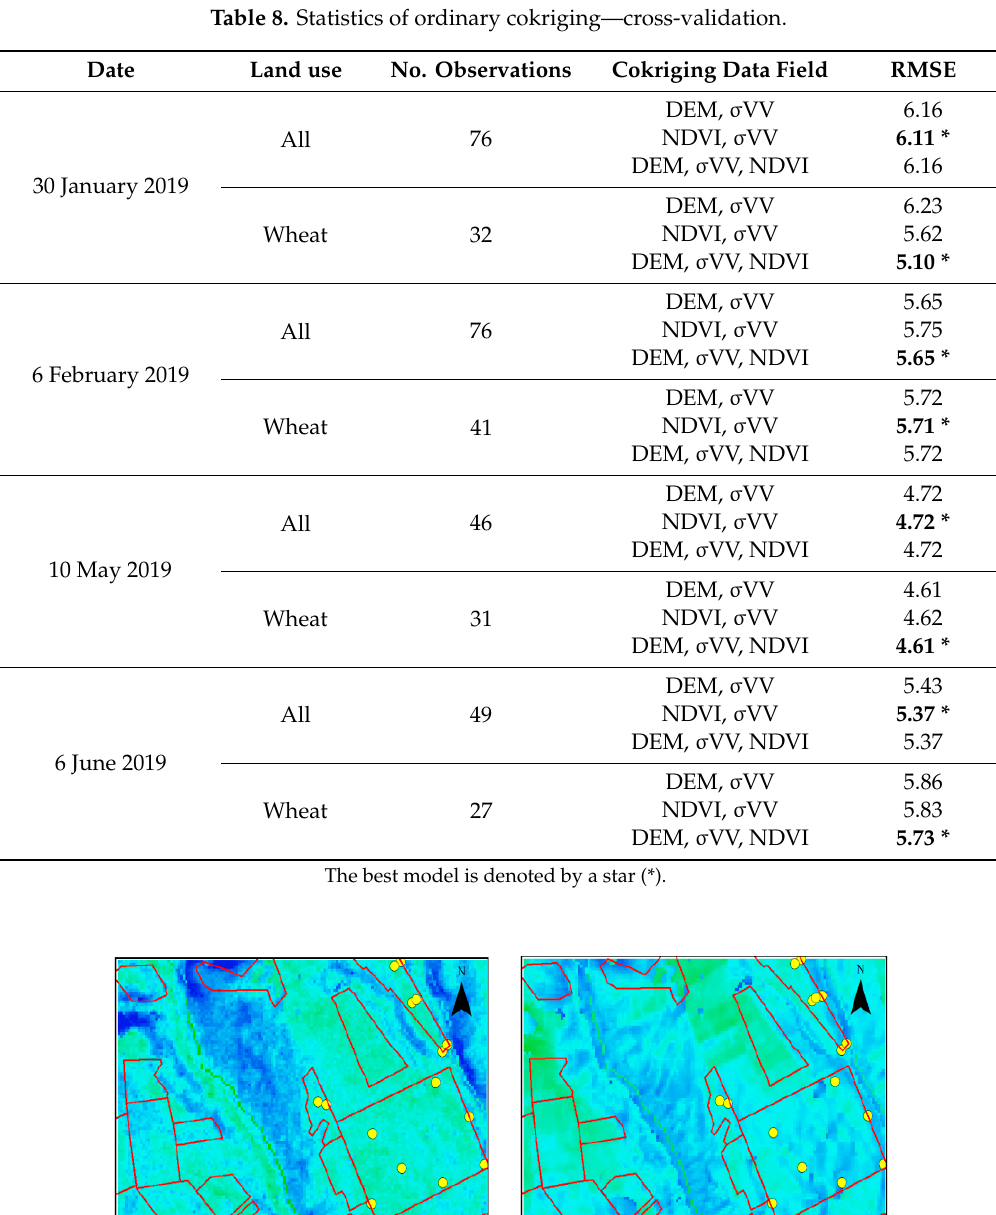
Table 8. Statistics of ordinary cokriging—cross-validation.